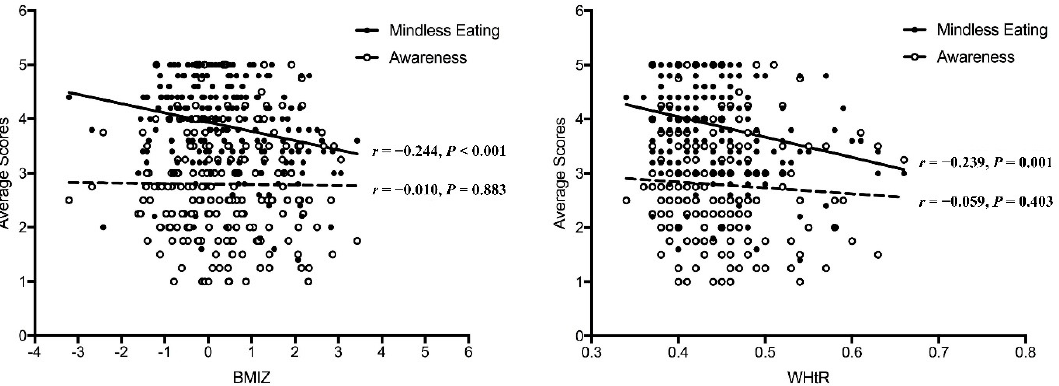
Figure 5. The associations between subscales and weight status. A case was excluded in the WHtR figure due to being an outlier (WHtR = 0.11, Mindless eating = 3.6, Awareness = 3).